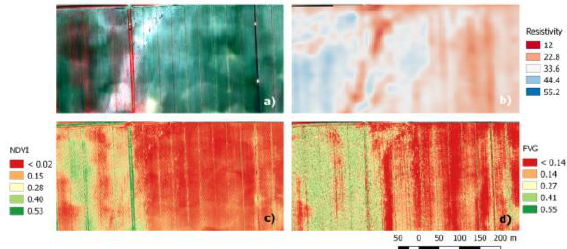
Figure 8. Results over the portion of the field were ESUs are located: a) Multispectral ortho-mosaic displayed as RGB false colour composite (R=NIR, G=red, B=green); b) soil resistivity; c) NDVI; d) FVC